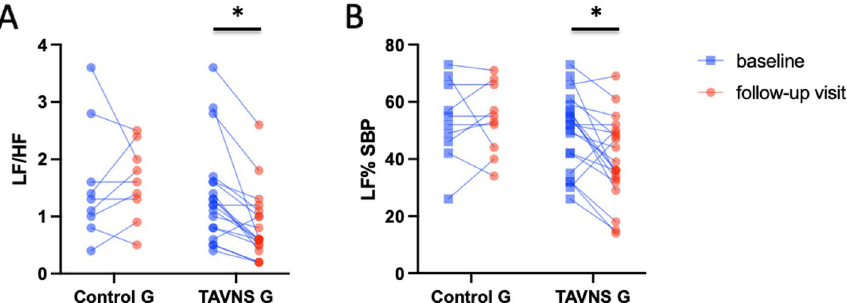
Fig. 3 Autonomic balance in control and TAVNS groups at baseline and after 8 weeks of follow-up. A LF/HF ratio, * p